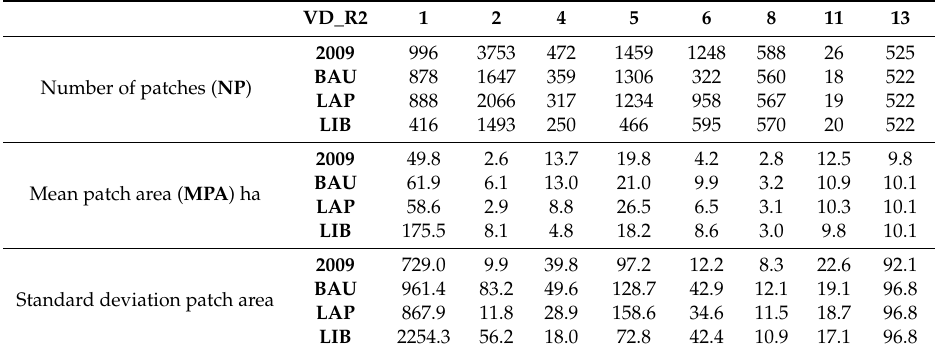
Table 10. Landscape fragmentation parameters for VD_R2: number of patches (NP), mean patch area (MPA) in ha, and standard deviation of the mean patch area, in 2009 and 2050 for each scenario and land use type.